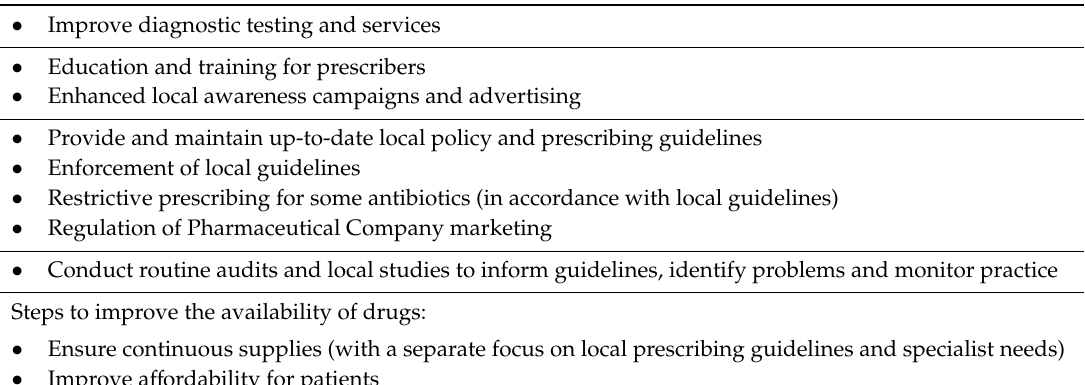
Table 2. Domains for antimicrobial stewardship programmes (AMS) actions as identified by